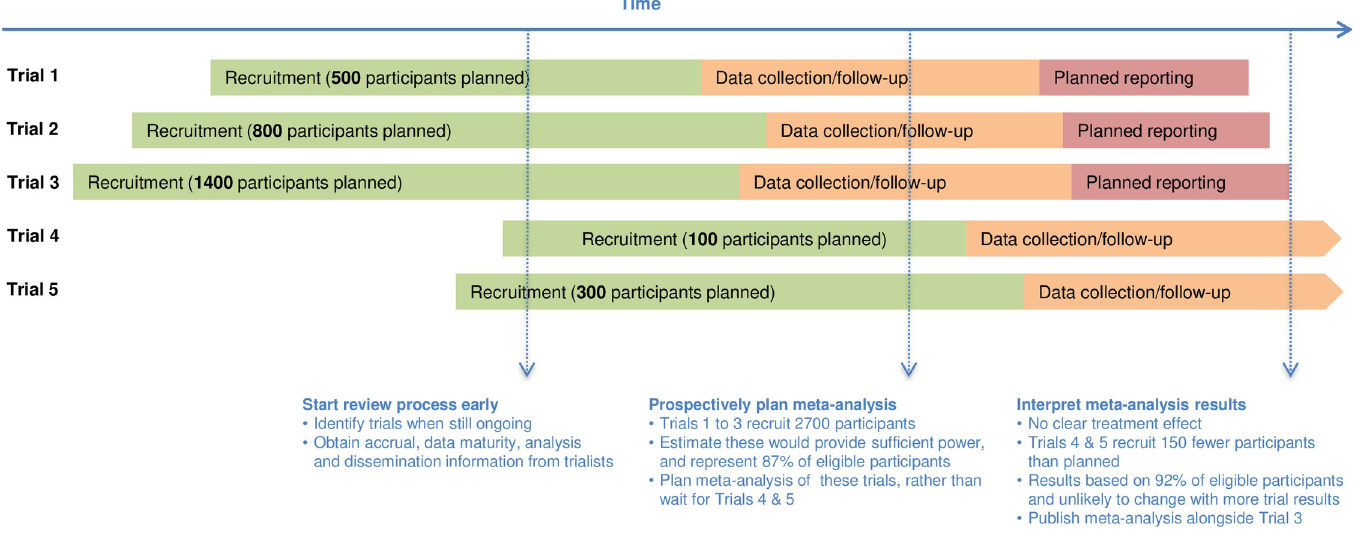
Fig 2. Visualising the application of FAME to a hypothetical systematic review of 5 randomised trials.